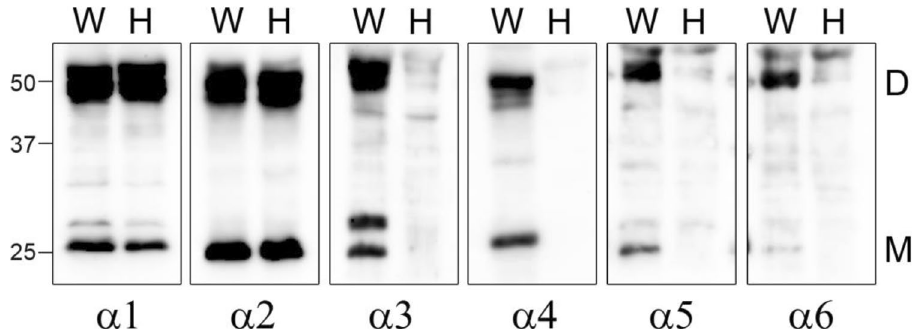
Figure 8. Western blot analyses of type IV collagen in Col4 α 5 mutant kidneys. Collagenase-solubilized renal basement membranes from wildtype (W) and Col4 α 5 mutant (H) males at 8 weeks of age were separated by SDS-PAGE and blotted with antibodies that the specifically recognized α1-6 (IV) NC1 domains. D: NC1 dimer, M: NC1